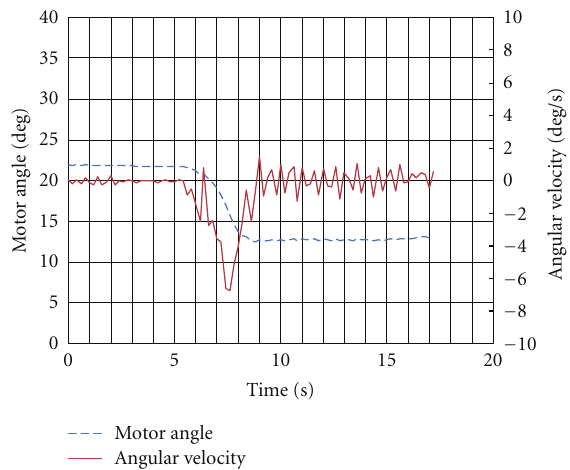
Figure 11: Rotation angle and angular velocity response of the motor when the step response with a 10-degree rotational angle is applied.